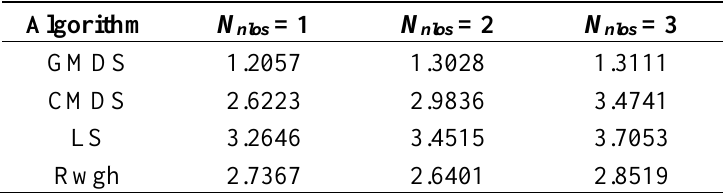
Figure 6. Performance of the tracking algorithms when 1 1 N  ; ( b ) Diagram of cumulative error distribution when 1 nlos Table 2. Average errors of localization